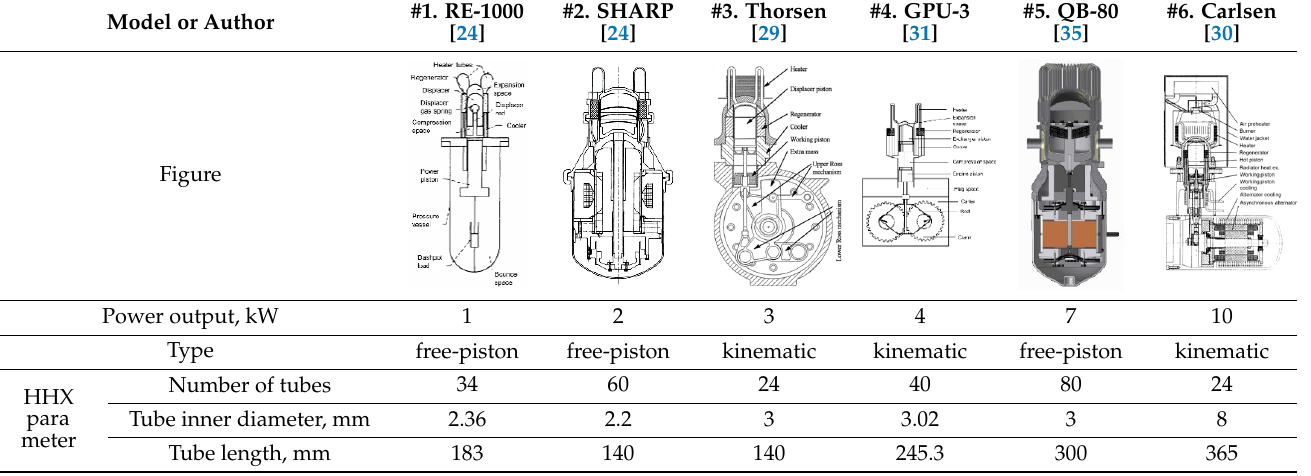
Table 2. Design parameters of HHX for several kilowatt-class Stirling engines from the literature.